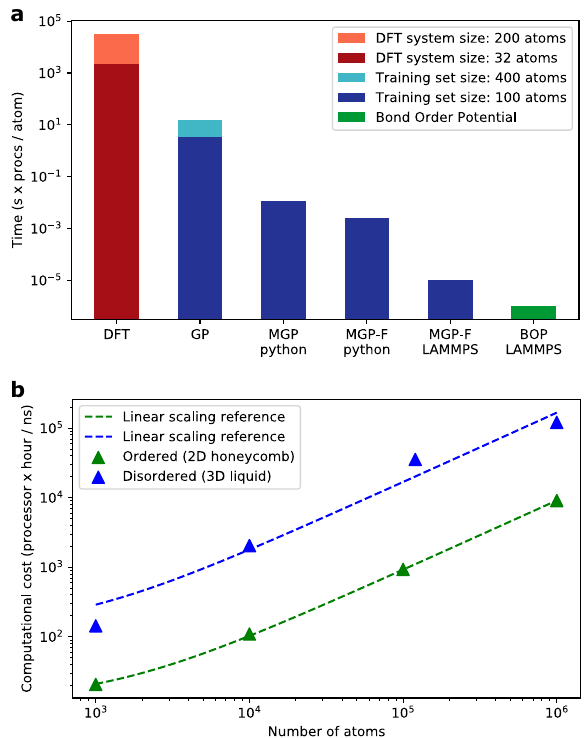
Fig. 5 Computational cost and scaling. a The comparison of prediction time (s × processors/atom) between DFT, full GP, MGP (Python, with force and uncertainty), MGP-F (Python, with force only), MGP (LAMMPS, with force only), and BOP (LAMMPS). b The scaling of MGP in LAMMPS with respect to different system sizes, in different phases. Green: 2D honeycomb lattice. Blue: 3D dense unit cell dimensions shrinking. Finally, patches of bcc lattice nucleate during the atomic rearrangement (Fig. 4a — 1.6 ns), and those patches grow until the whole system forms the crystal bcc slab and atoms start vibrating around the lattice sites (Fig. 4a — 2 ns).